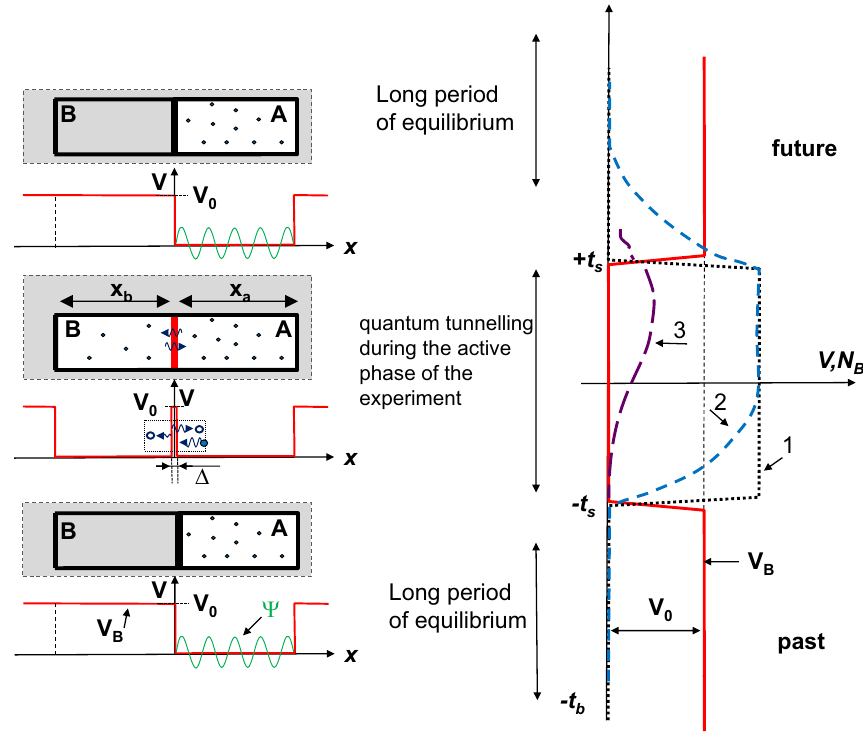
Fig. 1 System, which is isolated from the environment and screened from the temporal boundary conditions imposed on the universe by equilib- rium states, involves quantum tunnelling from section A to section B and back in response to the time-symmetric dis- turbance of the potential V B . Here, N B is expected number of particles in section B: 1 - under equilibrium, 2 - as predicted by master equations with dominant decoherence and by thermodynamic considera- tions; 3 - possible quantum solution without